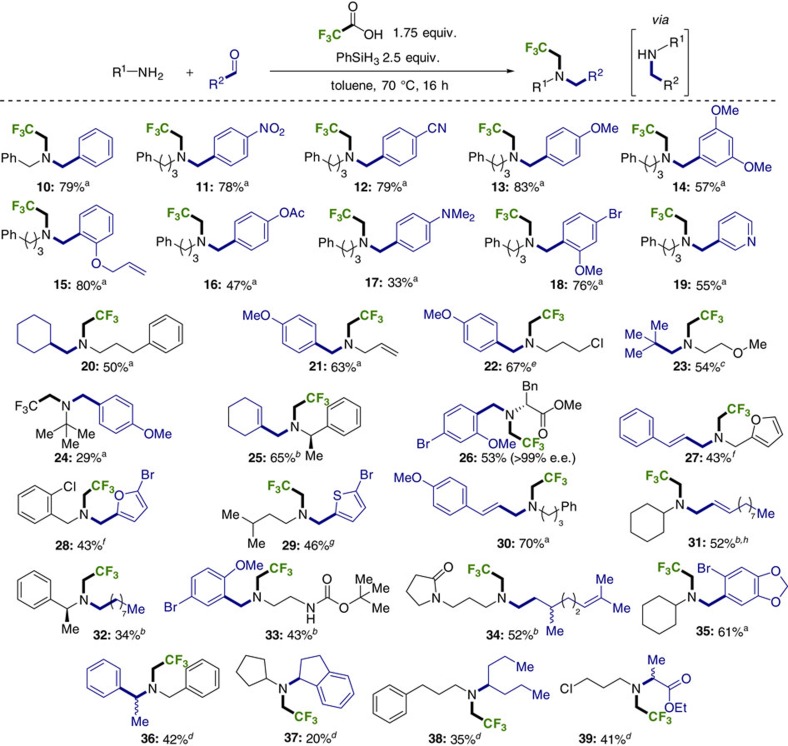
Three-component trifluoroethylation reactions.aTypically, amine (0.50 mmol) and aldehyde (0.50 mmol) were mixed neat, before adding toluene (0.5 ml) and PhSiH3 (0.25 mmol) and stirring for 10 min at 70 °C. Trifluoroacetic acid (0.875 mmol) and further PhSiH3 (2.0 mmol) were added and the reaction heated at 70 °C for 16 h. The products were purified by concentration, washing an ether solution of the crude material with sodium bicarbonate and chromatography. Slight timing/temperature modifications are described in Supplementary Methods for: bMethod B (alkyl aldehydes), cMethod C/D (hindered aldehydes), dMethod E (ketones). e5.00 mmol scale from HCl salt of amine, ftrifluoroacetic acid (1.50 mmol) used. gtrifluoroacetic acid (1.00 mmol) used, has mixture of 93:7 trans:cis alkenes.